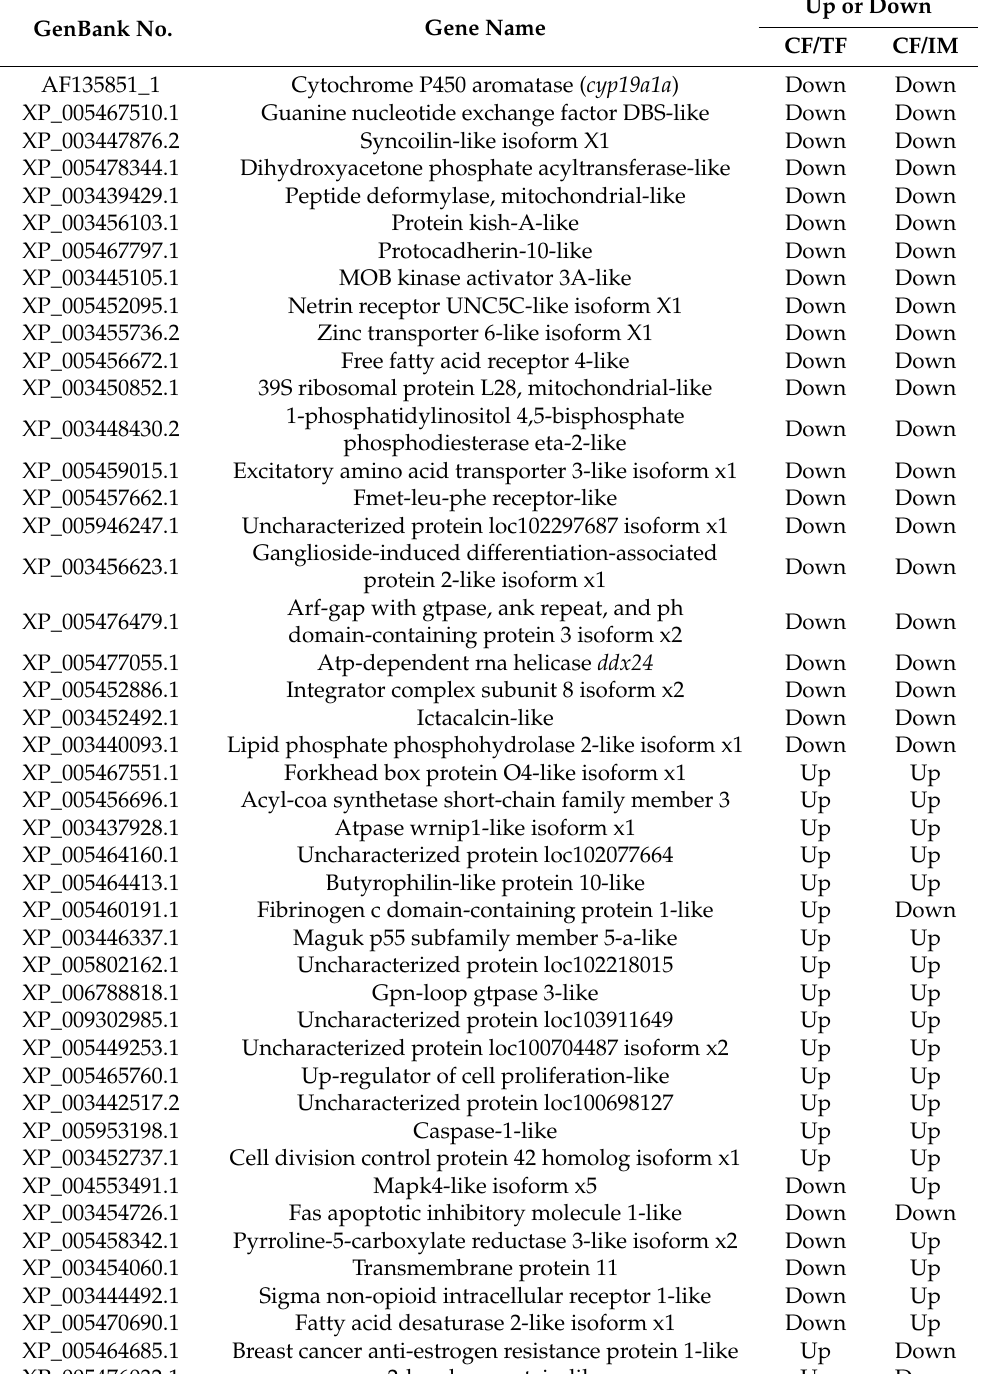
Table 2. Forty-five DEGs shared by the CF–TF and CF–IM